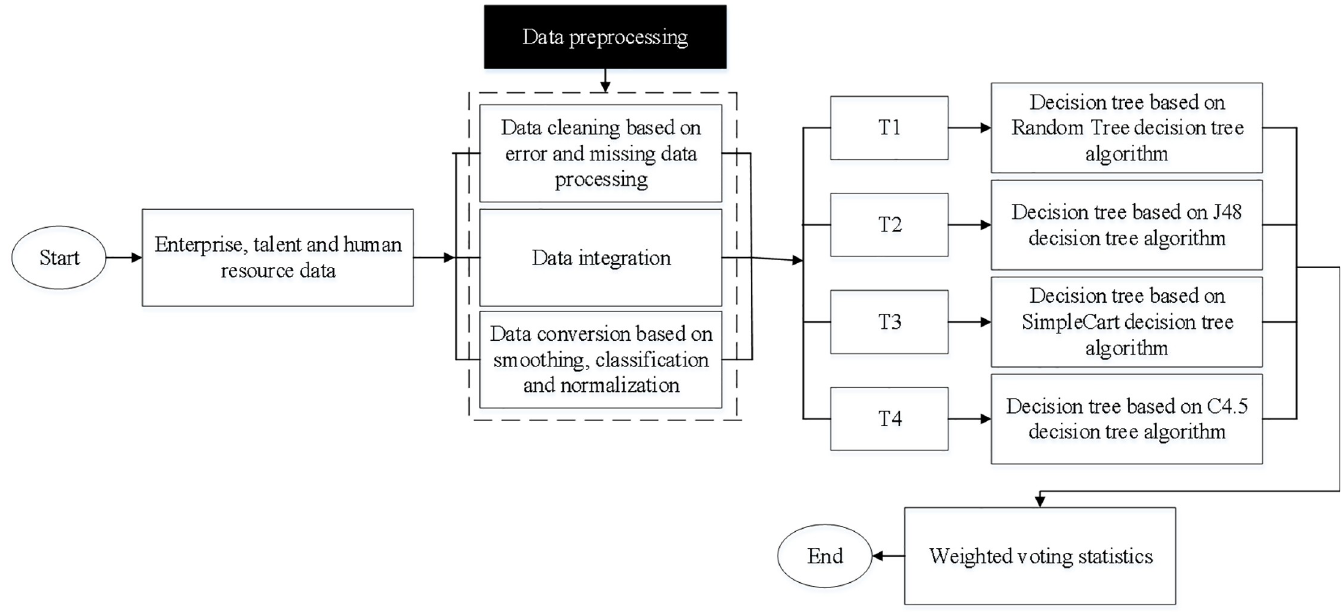
Fig 1. Implementation of ensemble classifier based on four decision tree algorithms.